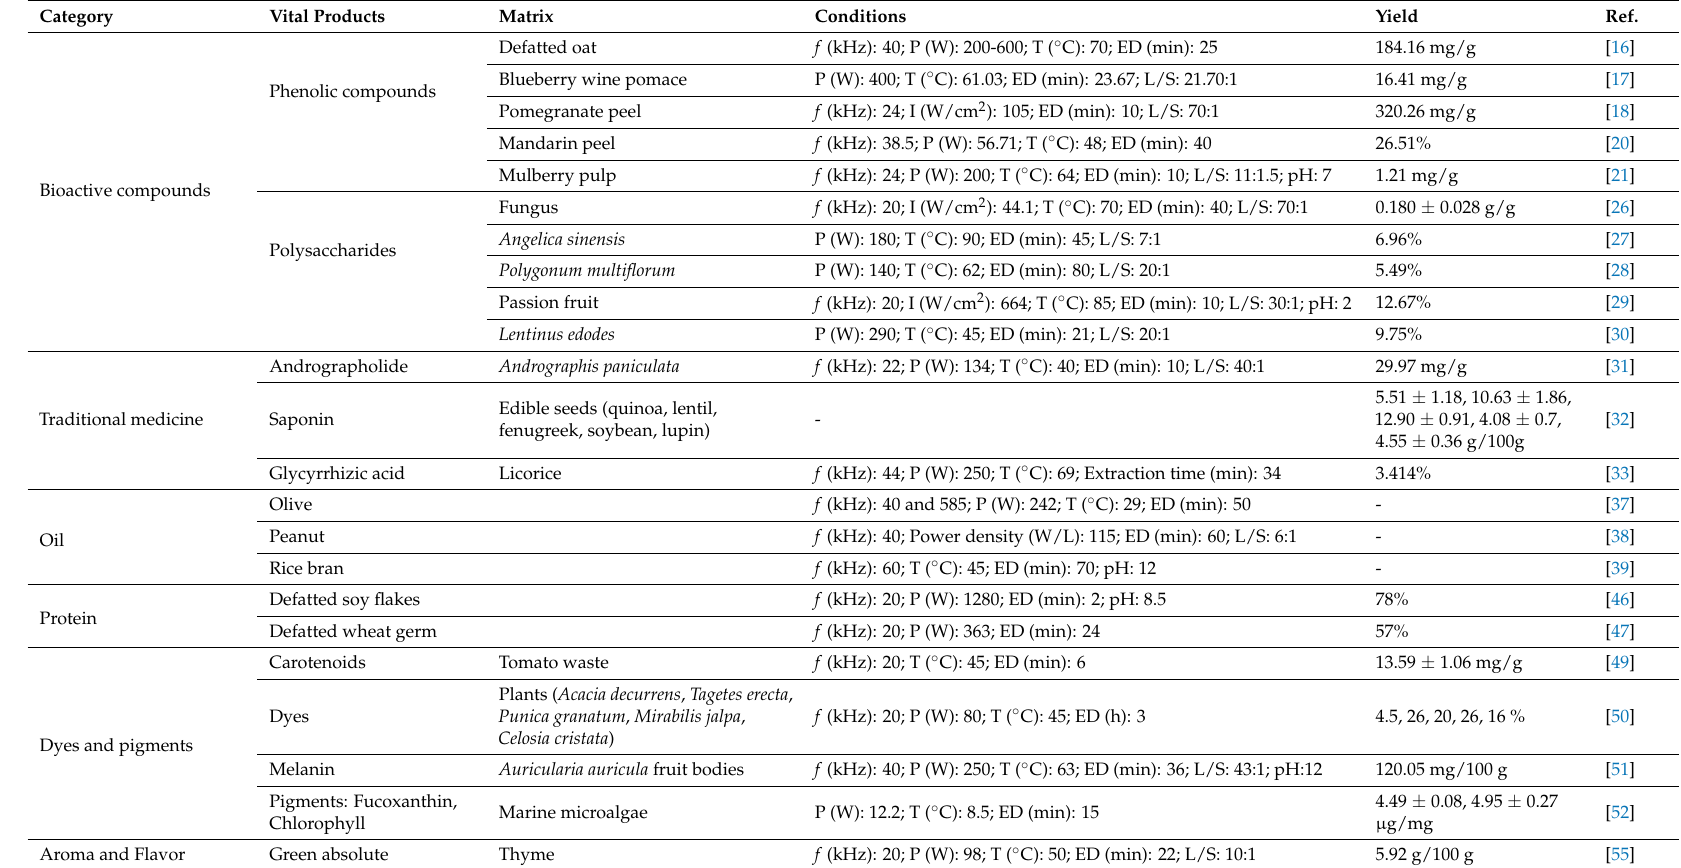
Table 1. Ultrasound-assisted extraction of vital